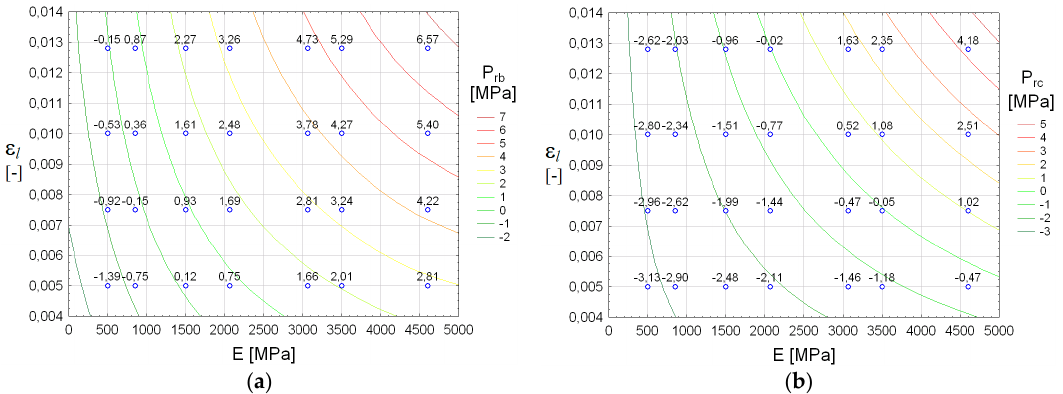
Figure 21. Maps of: ( a ) the rebound pressure P rb ; and ( b) the recovery pressure P rc , as correlated with E and ε l for the North-East of Fairway San Juan basin.